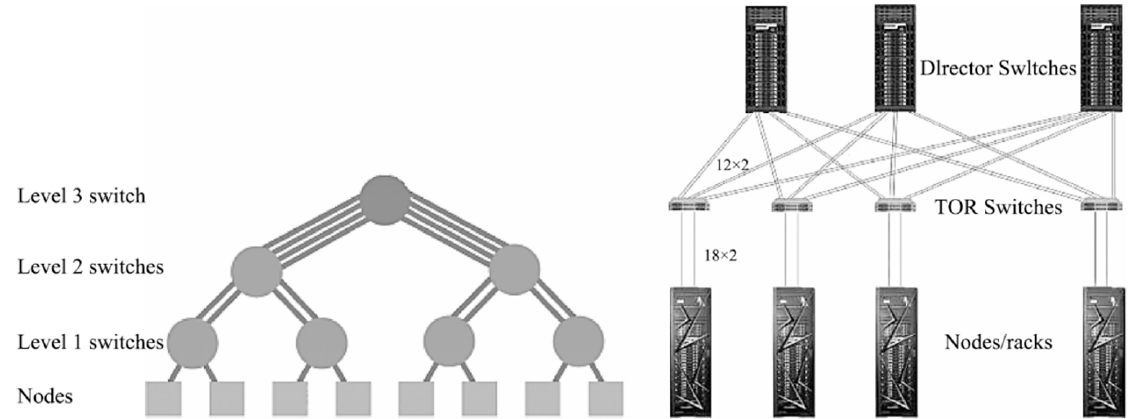
Figure 3. Topologies between cabinets in Summit and Sierra [21].